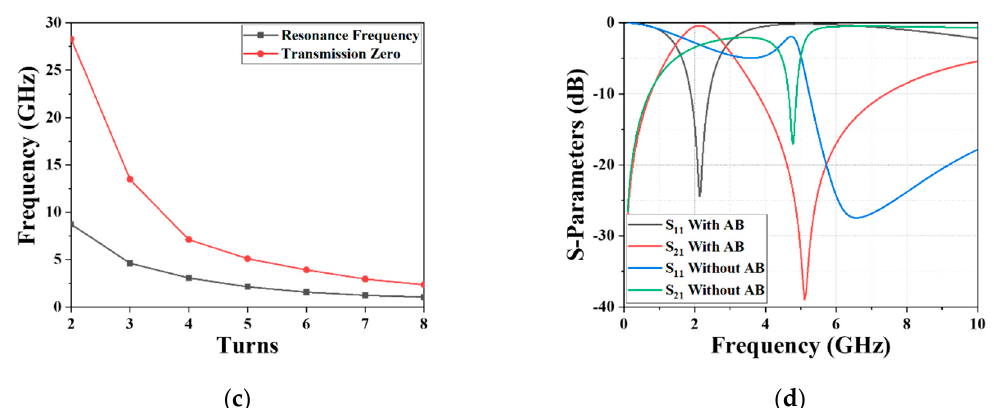
Figure 5. Effect of the varying inductor turns on ( a ) S11 and ( b ) S21; ( c ) functional relationship between the CF and the number of turns; ( d ) S-parameter comparison of the intertwined inductor with/without air-bridge structure.